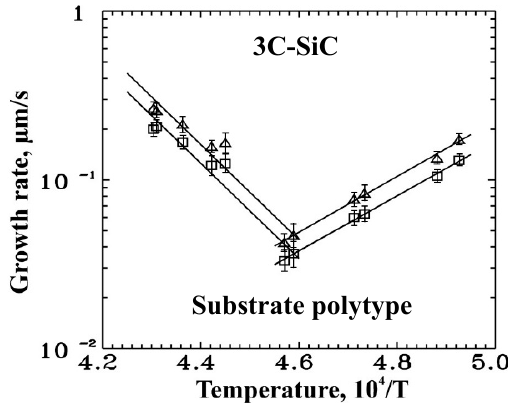
Figure 5. Critical growth rate versus substrate temperature for C-face (0001 ) -oriented 6H- and 15R-SiC using the modified sublimation sandwich method: □ – 6H-SiC; Δ – 15R-SiC.